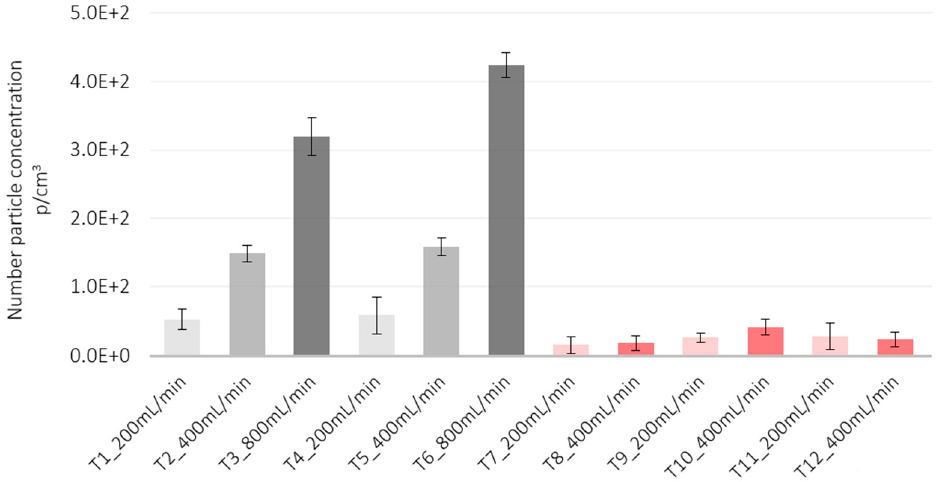
Figure 7. Histogram of particle number concentrations measured at the NF position. Particles size range 0.3–1µm. Grey bars TiO 2 -N; pink bars AgHEC.